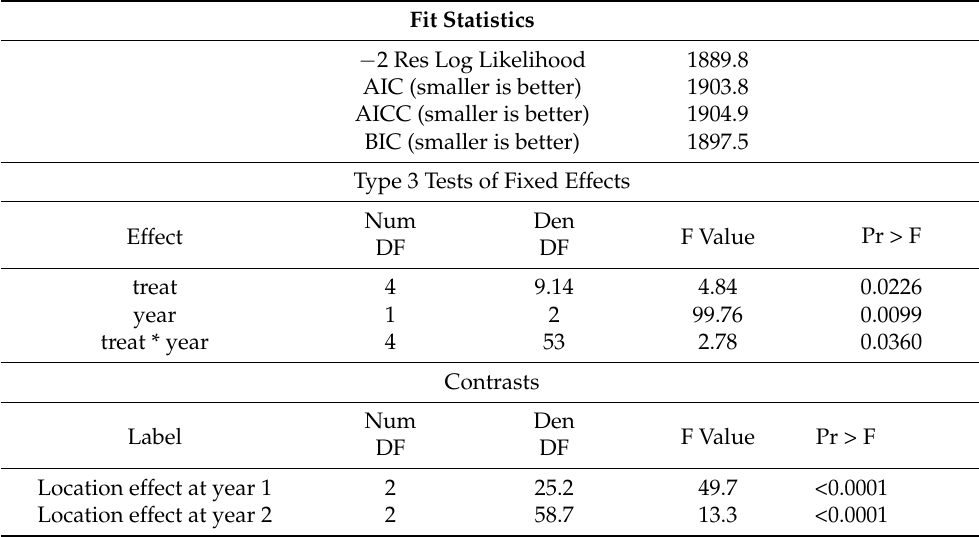
Table 6. Output 5: Partial output of the statistical analysis on the location-by-year interaction effect for the alfalfa